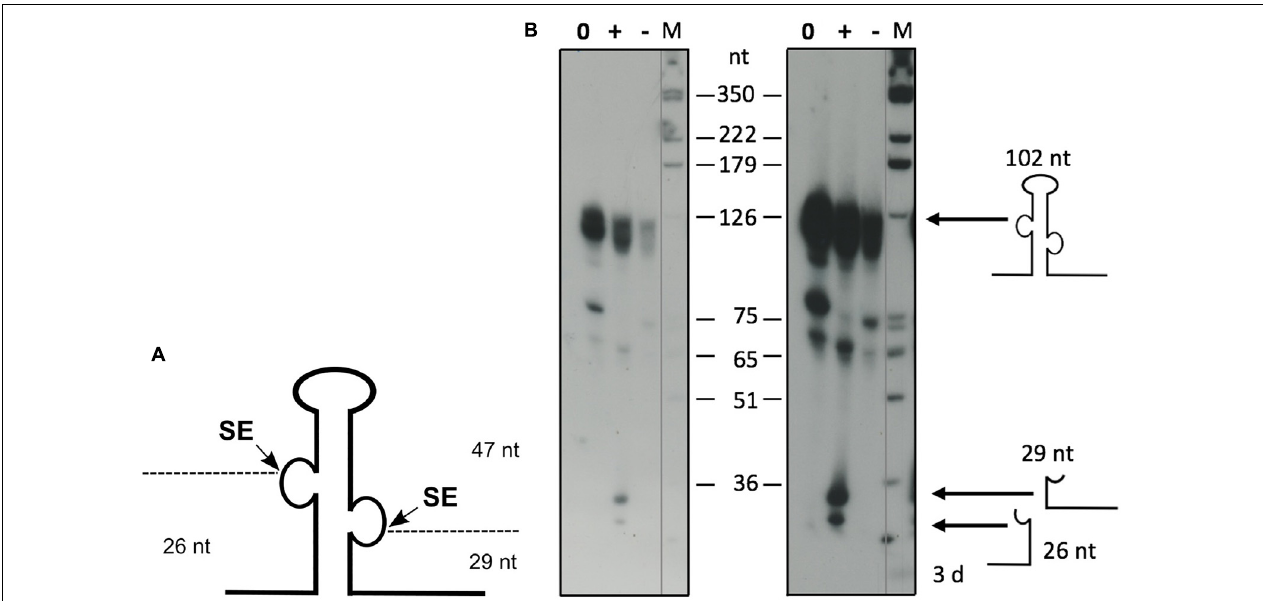
FIGURE 10 | In vitro processing of the newly identified BHB containing RNA. (A) Schematic drawing of the precursor substrate. As a substrate for the in vitro processing reaction, the 5 (cid:48) UTR of HVO_1309 was used, encompassing the intron flanked by the BHB motif with additional nucleotides up- and downstream. (B) Processing reaction. The substrate was transcribed in vitro and labeled throughout with [ α − − 32 P]-UTP. In vitro processing was performed with recombinant SE, and RNAs were separated by 8% PAGE. Samples were incubated for 60 min. A DNA size marker is given at the sides, and sizes are shown in the middle (M). A control reaction without enzyme was performed at the beginning and end of the reaction time (indicated as NC0 and NC60 for 0 and 60 min of incubation, respectively). Samples with enzyme were incubated for 60 min (SE). Left panel: short exposure, right panel: long exposure. The precursor RNA has a length of 102 nucleotides, and the processing fragments are 26, 29, and 47 nucleotides long. Substrate and processing products are shown schematically at the